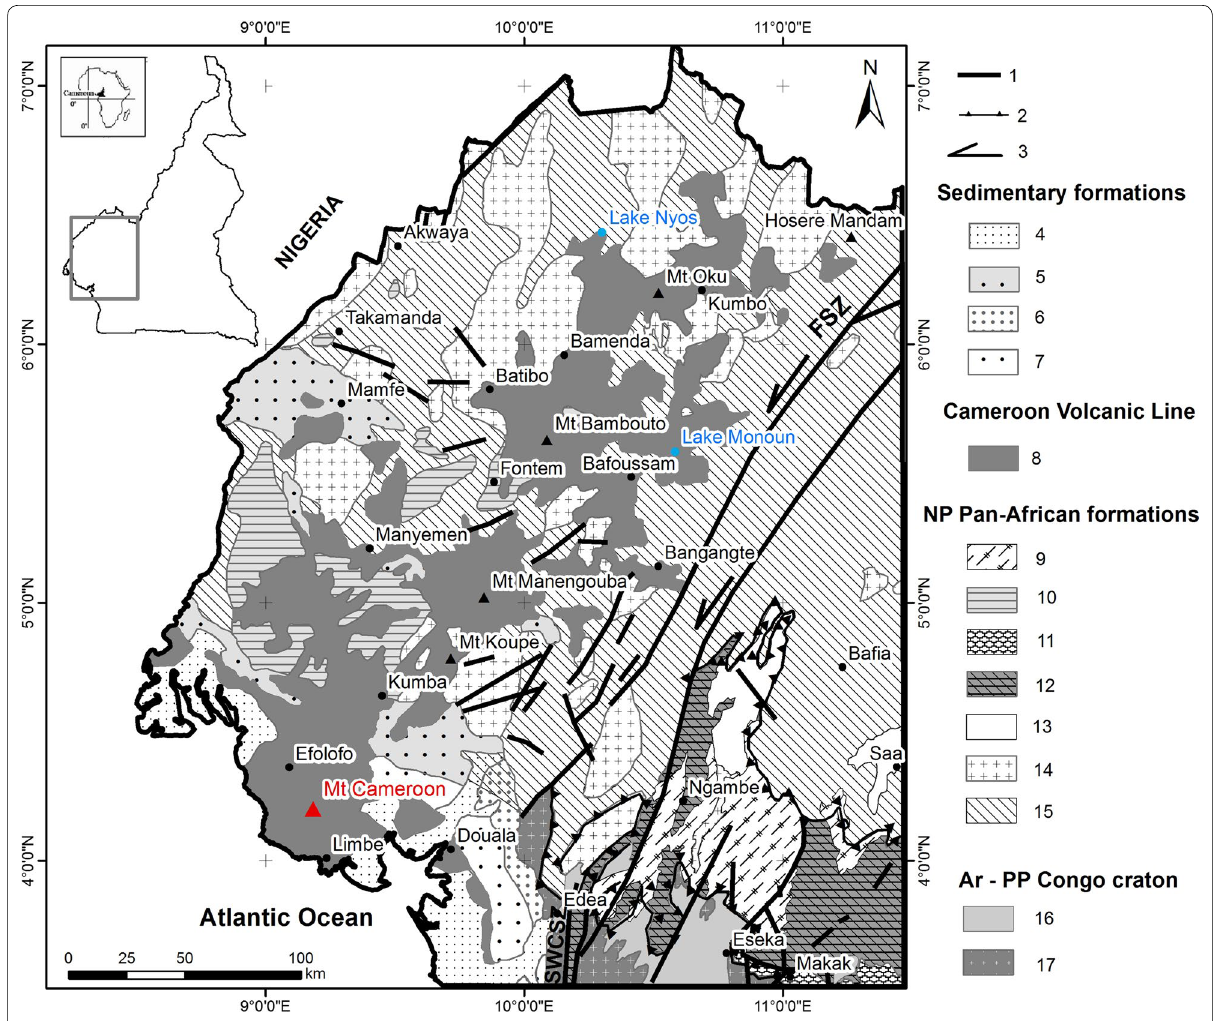
Fig. 2 Geological sketch map of the study area. FSZ Foumban shear Zone, SWCSZ South‑Western Cameroon Shear zone, NP Neoproterozoic, Ar Archean, PP Paleoproterozoic, 1 fault, 2 thrust, 3 Sinistral trike slip, 4 Paleo‑Neogene sand, 5 cenozoic sandstone and conglomerate, 6 upper cretaceous sandstone, 7 lower cretaceous sandstone, 8 cenozoic to actual volcanism, 9 garnetiferous gneiss, 10 lower gneiss, 11 schist from Yaounde Group, 12 gneiss and micaschist from Yaounde Group, 13 Quartzite, 14 Syn to late tectonic granitoid, 15 Pre to syn tectonic granitoid, 16 greenstone belt. Granitoid Complex of Nyong Group (modified from Koch 1953; Champetier de Ribes and Aubague 1956; Weecksteen 1957; Champetier de Ribes and Reyre 1959; Dumort 1968; Peronne 1969; Nsifa et al. 2013). The deadly maar lakes are highlighted in blue and Mount Cameroon in